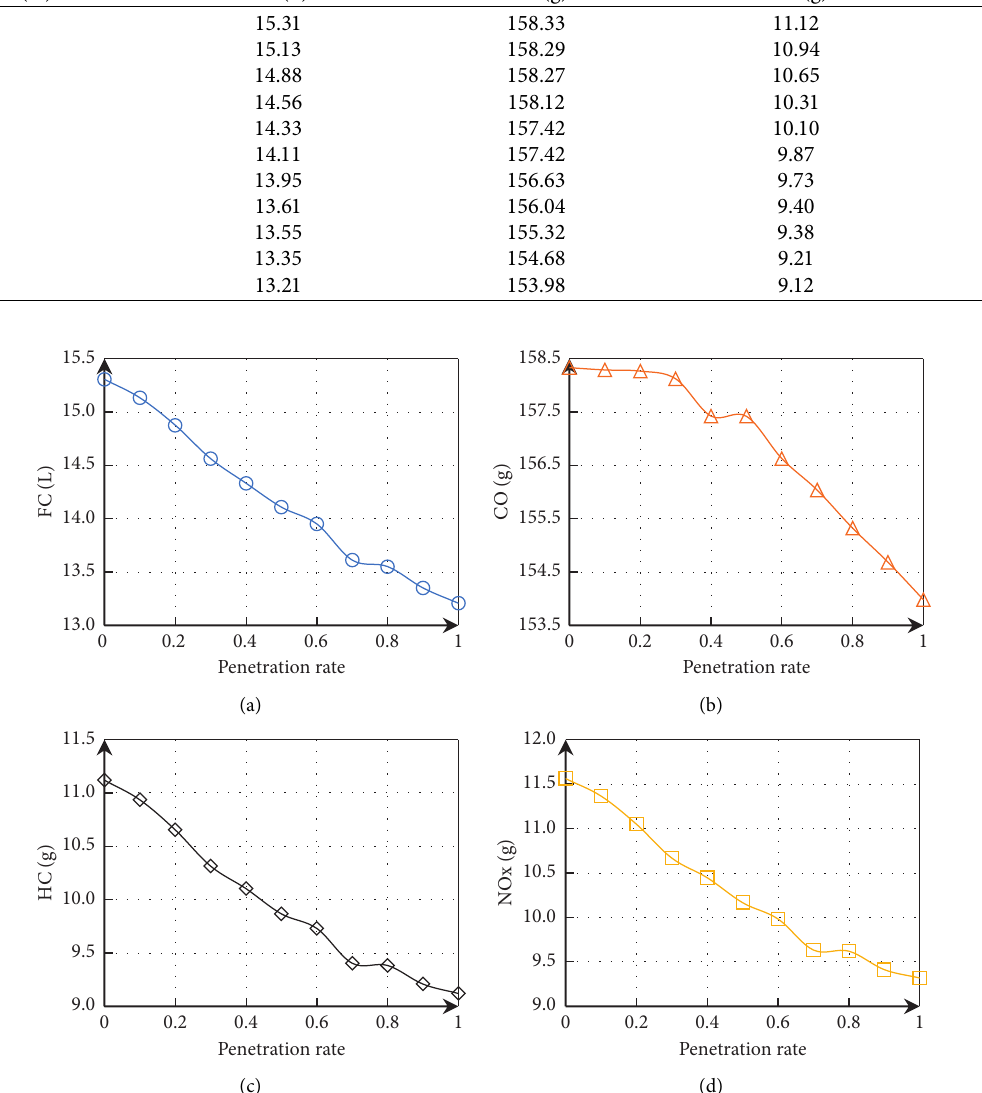
Table 3: Fuel consumption and traffic emissions under different CAVs penetration rates (Scenario 1). Penetration rate